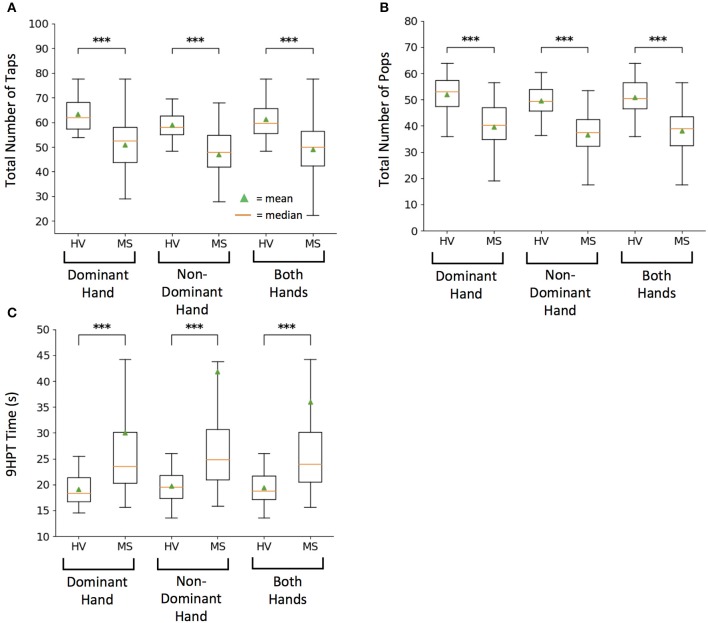
Healthy volunteer (HV) and Multiple Sclerosis (MS) cohort comparison for raw scores on tests. (A) Smartphone-developed tapping test measuring total number of taps in 10 s. (B) Smartphone-developed balloon popping test measuring total number of randomly generated balloons popped in 26 s. (C) Current clinical motor function exam, 9-hole peg test (9HPT) measuring time for completion. Lower 9HPT time is considered the better outcome. For each test, box plots represent group values based on diagnosis, where each subject is represented by an average of two independent attempts, with intra-individual outliers excluded as described in methods. On each box plot, green triangles indicate the mean and orange lines indicate the median of depicted cohort datasets. Box plot box boundaries represent the Q1 to Q3 range centered about the median. Box plot whisker lengths extend to Q1–1.5 *IQR and Q3 + 1.5 *IQR. ***p < 0.0001.